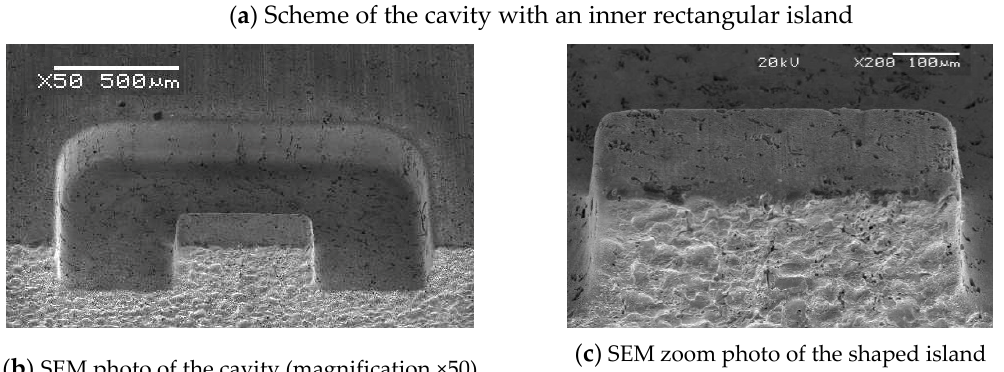
( c ) SEM zoom photo of the shaped island (magnification ×200 of the cavity presented on the left side) Figure 21. Schemes ( a ) and photographs ( b , c ) of the machined cavity with an inner rectangular island [33].